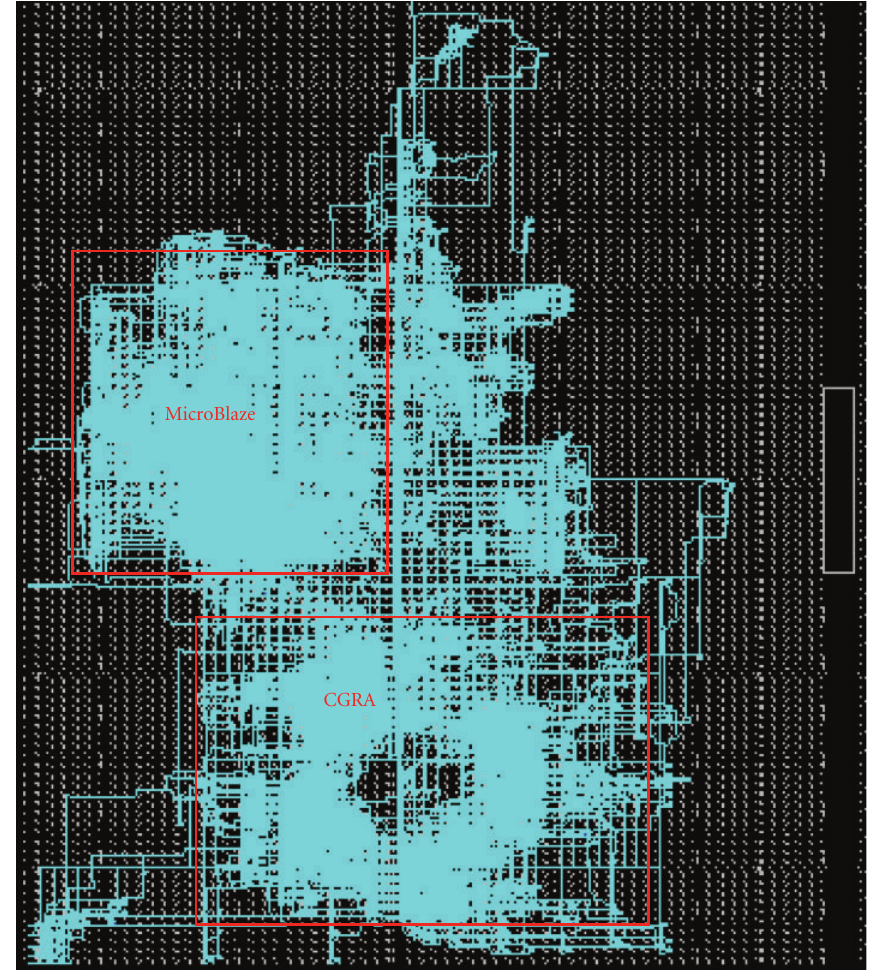
Figure 14: A resulting layout with a MicroBlaze connected to a coarse grained reconfigurable architecture through FSL.